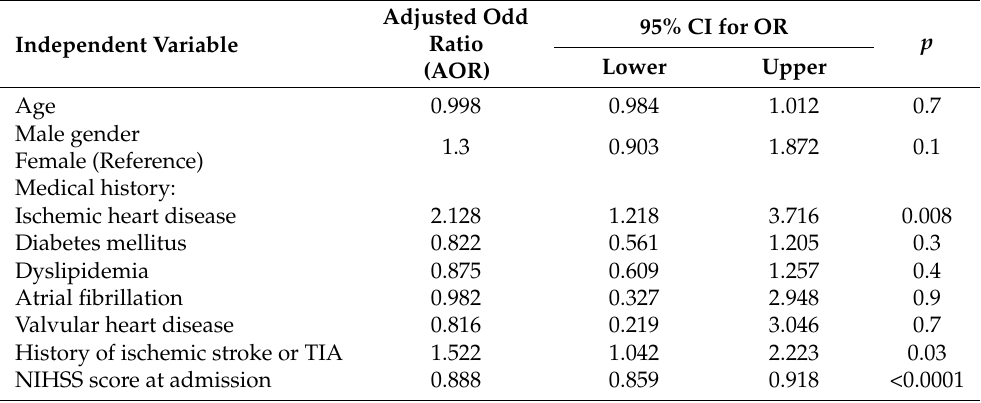
Table 3. Multivariate logistic regression analysis of small-vessel occlusion (SVO) “(LS)” in ischemic stroke